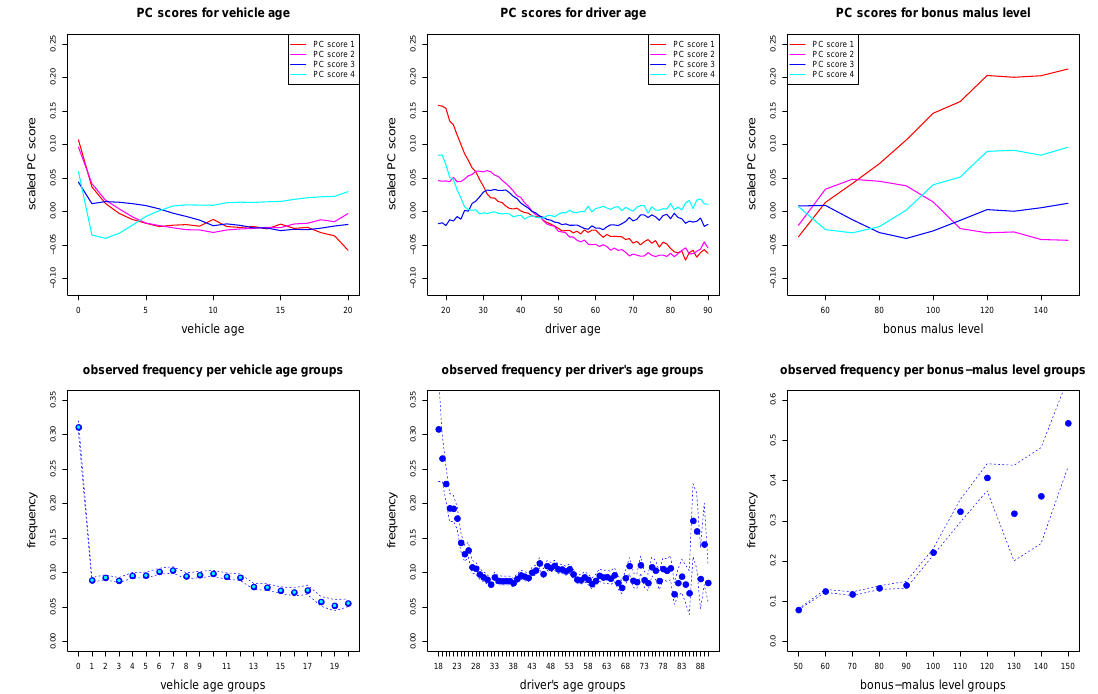
Figure 10. ( top ) Scaled principal component (PC) scores on the first 4 principal components averaged over the corresponding vehicle ages (lhs), driver ages (middle), and bonus males levels (rhs); ( bottom ) observed (empirical) marginal frequencies of vehicle ages (lhs), driver ages (middle), and bonus males levels